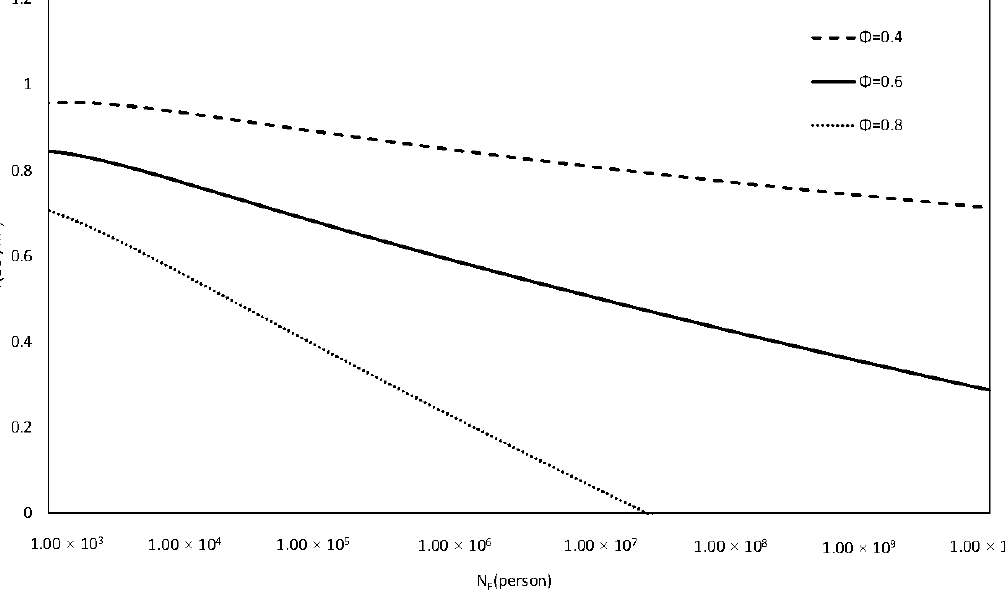
Figure 3. Relation of trading volume in RMB (Chinese money) to rural population N F . (The trading volume is the transaction volume T multiplied by the transaction price P mar .). 4.2. Maximum Acceptable Transaction Cost For Equation (16), if transaction cost index Φ is higher than a certain threshold, it could not achieve a reasonable root T , which means that water trading cannot occur because the transaction cost exceeds what the industrial sector can accept, and it is not worth taking part in water trading for industrial firms. That threshold is Φ max . To further explore the relationship between water market performance and transaction cost, the maximum transaction cost the water market can tolerate ( Φ max , the maximum value of Φ for which Equation (16) in Section 3.1 has a reasonable root T ) is calculated with different values of ALPF (Figure 4).